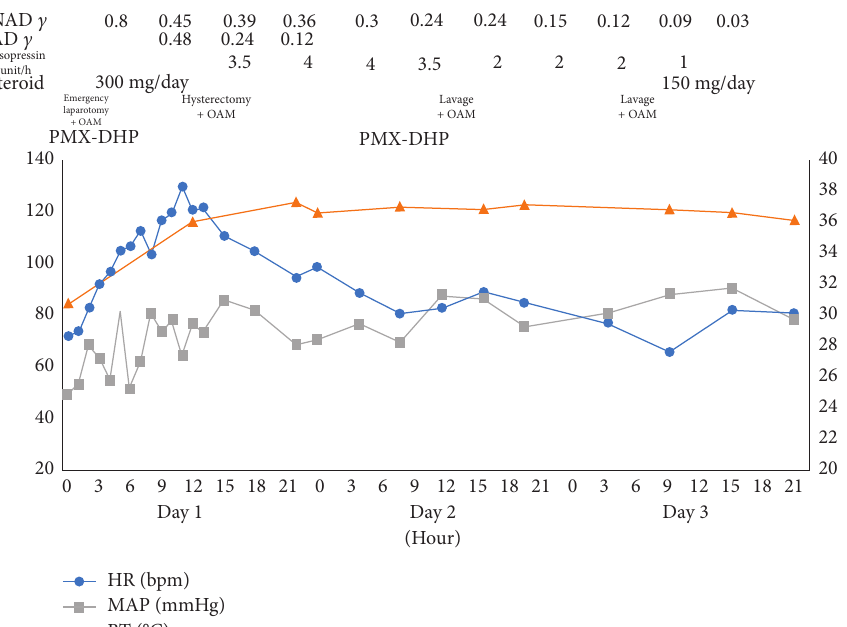
Figure 2: Clinical course after admission. Since the patient was initially in severe septic shock, intensive care was given according to the damage control strategy. As a result, her circulatory dynamics became stable by the end of the day. NAD, noradrenaline; AD, adrenaline; OAM; open abdomen management; PMX-DHP, direct hemoperfusion with polymyxin B-immobilized fibers; HR, heart rate; MAP, mean arterial pressure; BT, body temperature.